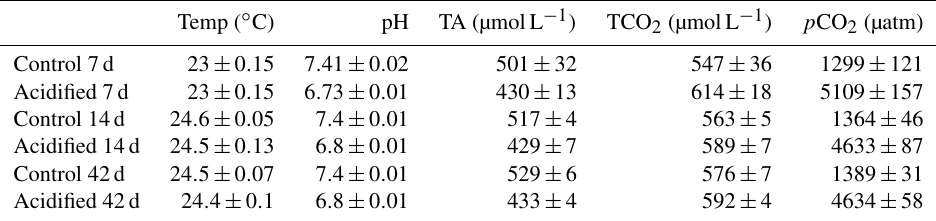
Table 1. Measured tank parameters for 7, 14, and 42d experiments of control and CO 2 acidified freshwater (FW). Measured parameters include temperature, pH (NBS scale), total alkalinity (TA), total CO 2 (TCO 2 ), and partial pressure of CO2 ( p CO 2